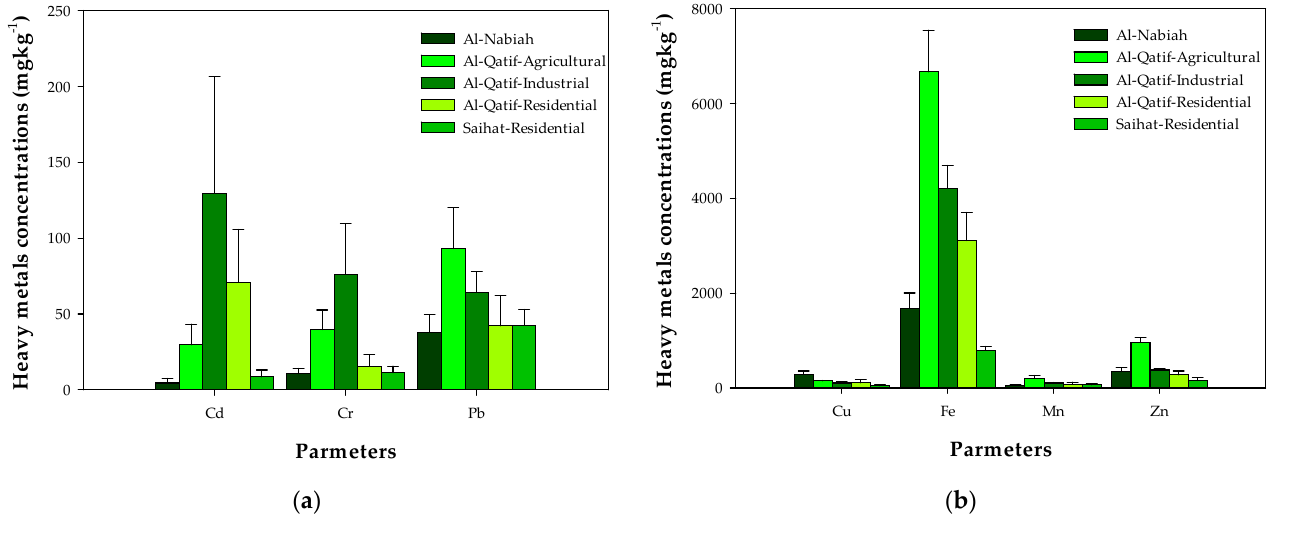
Figure 2. Heavy metals concentration Cd, Cr, Pb,( a ) Cu, Fe, Mn, and Zn ( b ) in AC filters from different sampling sites.